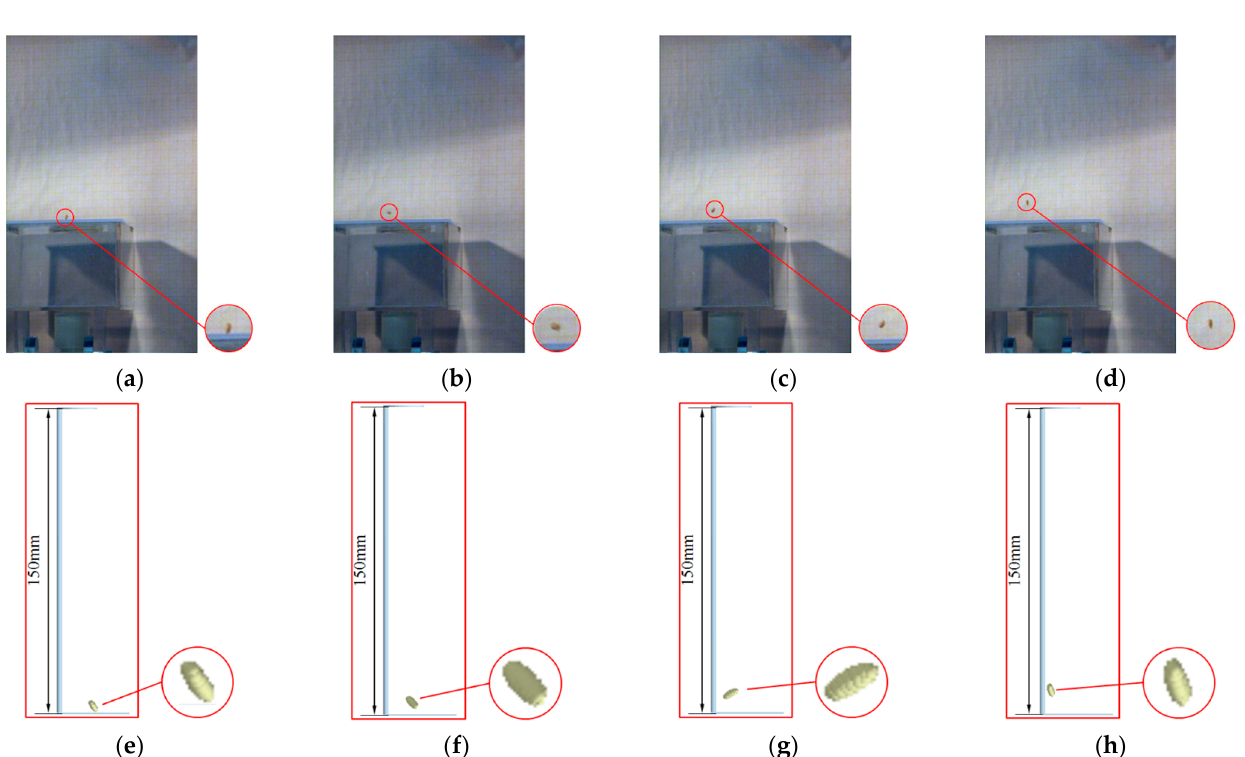
Figure 12. Comparison of motion state of rice grain before and after collision. ( a )–( d ) is the bench test; ( e )–( h ) is the simulation test: ( a ) before collision (0.10 s Y state); ( b ) after collision (0.11 s Y state); ( c ) after collision (0.12 s Y state); ( d ) after collision (0.13 s Y state); ( e ) before collision (0.10 s Y state); ( f ) after collision (0.11 s Y state); ( g ) after collision (0.12 s Y state); and ( h ) after collision (0.13 s Y state).